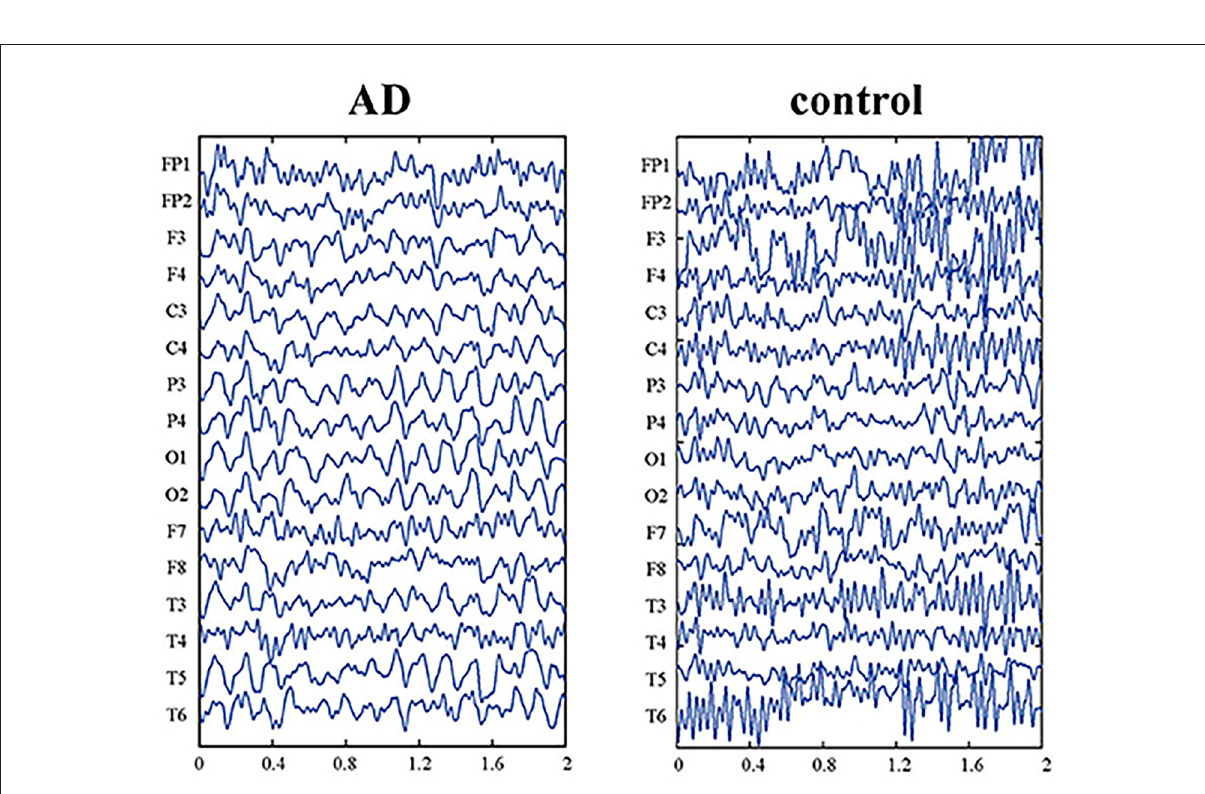
FIGURE8 EEG data of Alzheimer’s patient (AD) and normal aging person (control). The picture is reprinted from Yu et al. (2020) with permission.